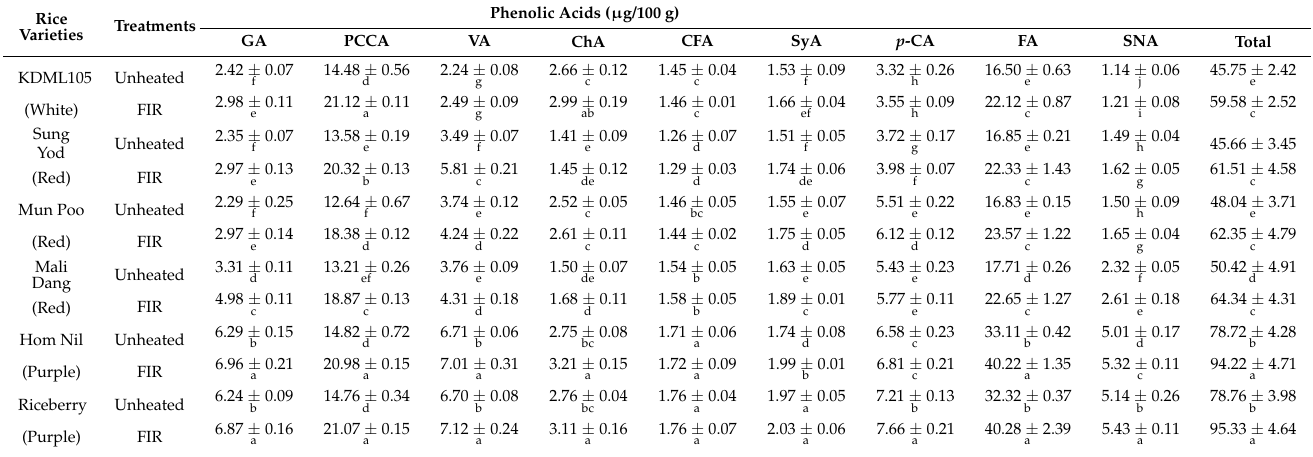
Table 1. Identifications of phenolic acids in pigmented rice varieties as affected by